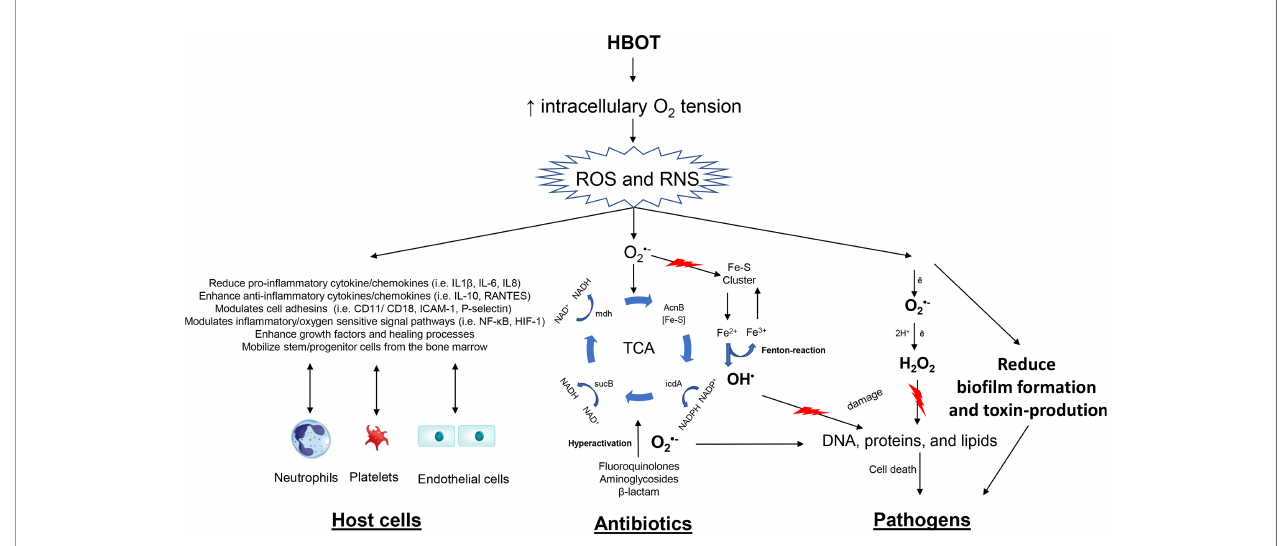
FIGURE 1 | Overview on therapeutic mechanisms of hyperbaric oxygen (HBOT). The fi gure outlines effects that occur due to increased production of reactive oxygen species (ROS) and reactive nitrogen species (RNS) because of hyperoxia. Oxygen-dependent antibiotics stimulate oxidation of NADH via the electron transport chain that is dependent upon the tricarboxylic acid (TCA) cycle. Hyperactivation of the electron transport chain stimulates superoxide formation. Superoxide damages iron-sulfur clusters, making ferrous iron available for oxidation by the Fenton reaction. The Fenton reaction leads to hydroxyl radical formation, and the hydroxyl radicals damage DNA, proteins, and lipids, which results in lethal bacterial killing. This mechanism is further enhanced by HBOT potentiating antibiotics. HBOT has a direct effect on pathogens increasing reducing growth rates and toxin-production. The important immunomodulatory effects of HBOT on neutrophils, platelets and endothelial cells are